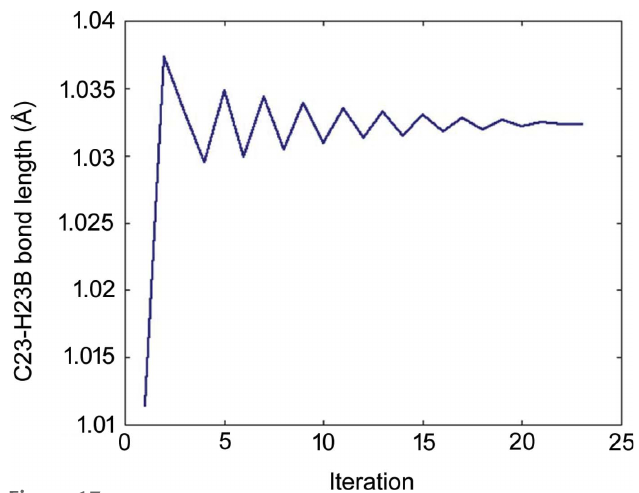
Figure 17 Oscillatory behaviour of the C23—H23B bond length (MUBOI structure) during HAR (for the version with